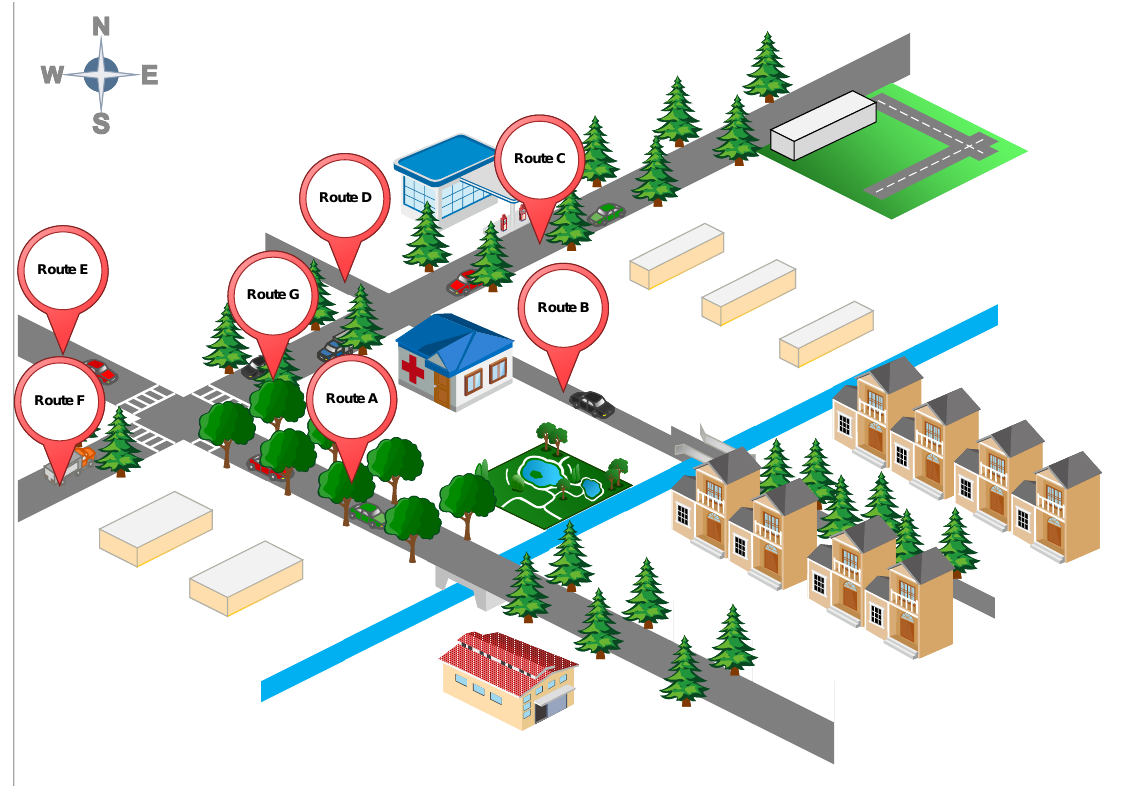
Figure 1. An example of road structure.